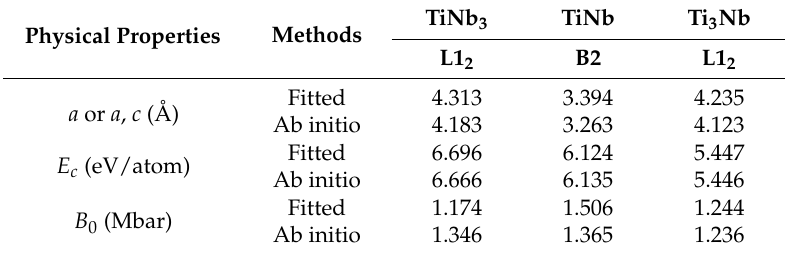
Table 3. The lattice constants ( a , c ), cohesive energies ( E c ), and bulk modulus ( B 0 ) of Ti-Nb hypothetical compounds fitted by the potential (first line) and calculated from ab initio (second line).